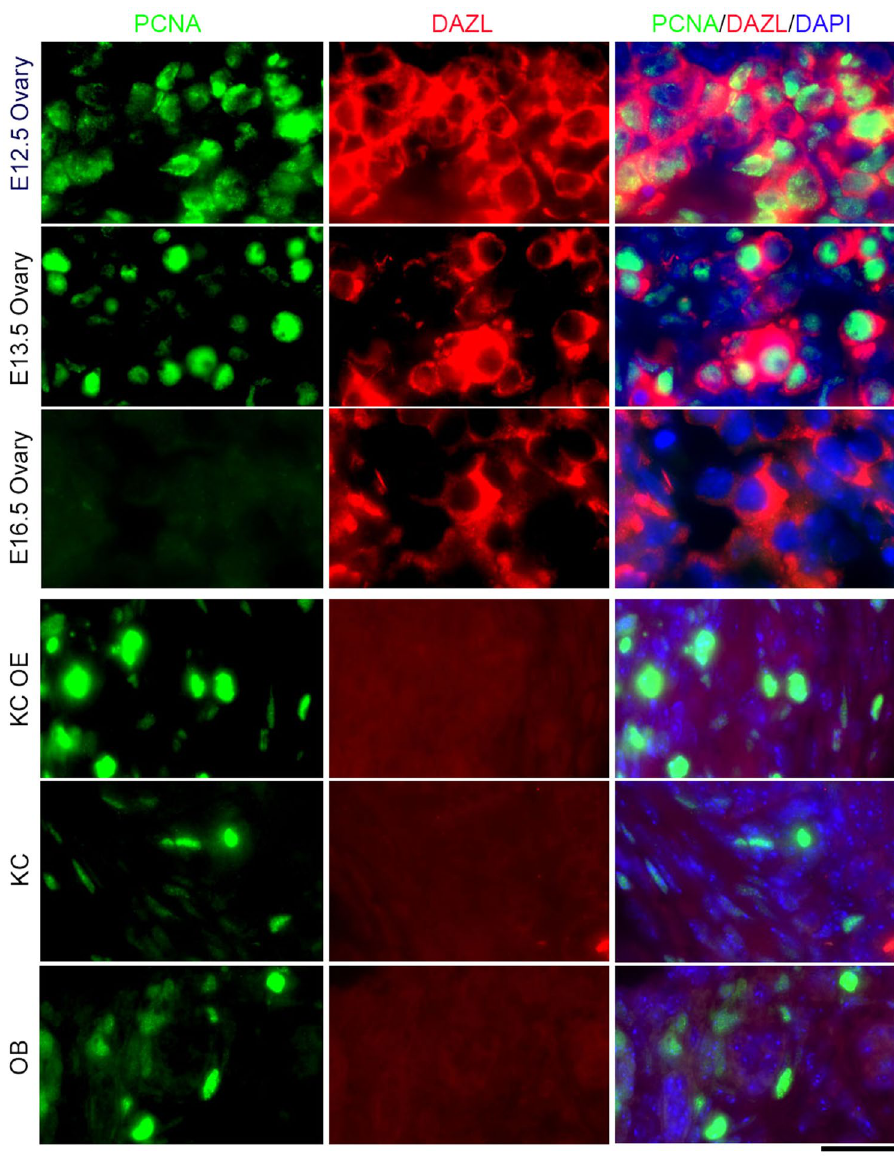
Figure 5. Loss of proliferative germ cells in grafts 28 days following transplantation of PGCs-aggregates. Co- immunostaining of proliferative marker PCNA and germ cell marker cytoplasmic DAZL in E12.5, E13.5 and E16.5 fetal ovaries (upper), and in grafts (bottom) by different methods of transplantation. Scale bar = 20 μ